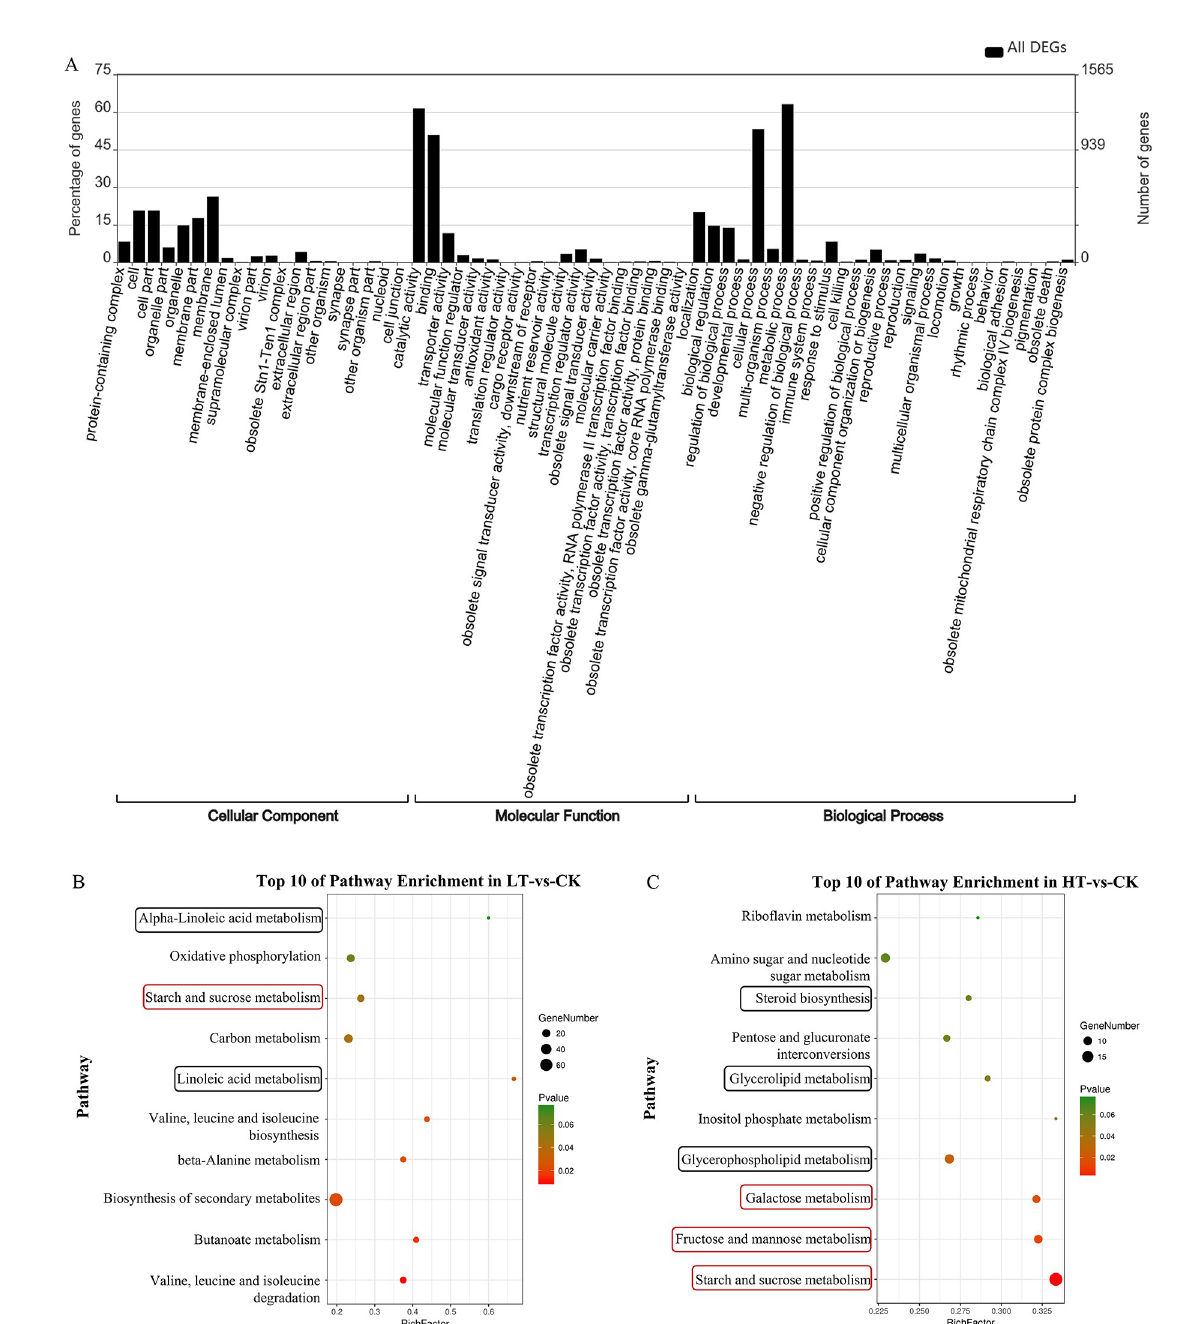
Fig 4. GO and KEGG pathway enrichment analyses of the DEGs under different temperature stresses. (A) The enriched GO terms of all the DEGs in response to temperature stress. (B, C) Top 10 enriched pathways in LT-vs-CK and HT-vs-CK, respectively. The black boxes represent the lipid metabolic pathways, while the red boxes represent the sugar metabolic pathways. GO, Gene Ontology. KEGG, Kyoto Encyclopedia of Genes and Genomes. DEGs, differentially expressed genes. LT, samples incubated at 22˚C. CK, samples incubated at 30˚C. HT, samples incubated at 42˚C.